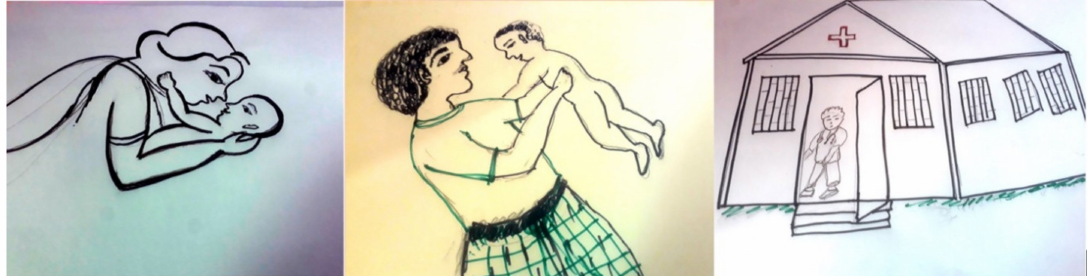
Figure 2. Examples of drawings demonstrated to facilitate participatory research (drawn by Debashish Chakravorty). The first two drawings on mother–child love and father–child love were generated following the clip art from the internet [31,32]. The third drawing on health care facility was generated based on the contextual experience from the first round of data